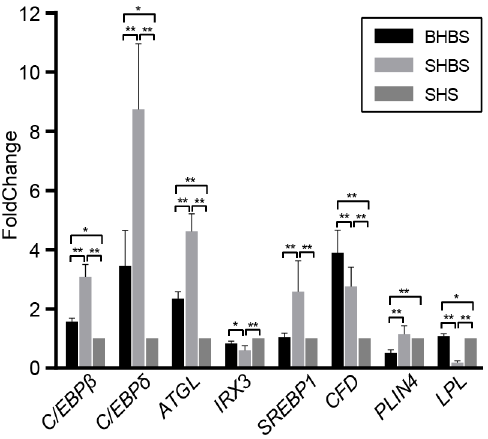
Figure 2. Relative mRNA expression levels of C/EBP β , C/EBP δ , ATGL , IRX3 , SREBP1 , CFD , PLIN4 , and LPL in 3 sheep breeds. The mRNA levels of genes involved in lipid metabolism were determined by qRT-PCR (analyzed by the ΔΔ Ct method with β -actin as the internal reference, ± SD). * means a significant difference at p < 0.05 level and ** means that at p < 0.01 level.